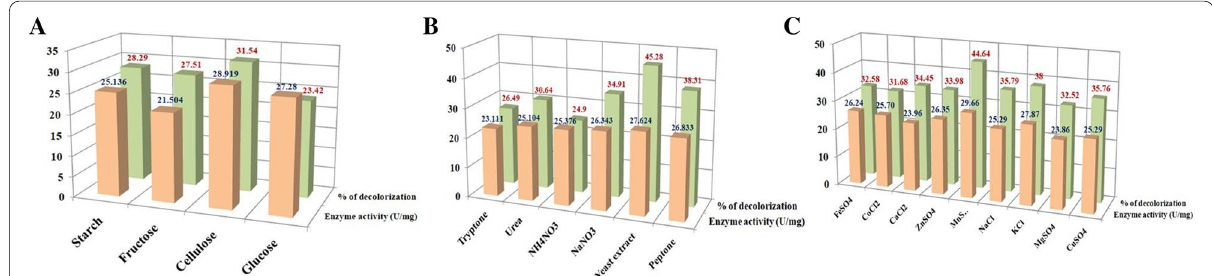
Fig. 6 Effect of different carbon sources ( a ), nitrogen sources ( b ), and metal ion sources ( c ) on LiP activity and dye decolourization by the bacterium Bacillus